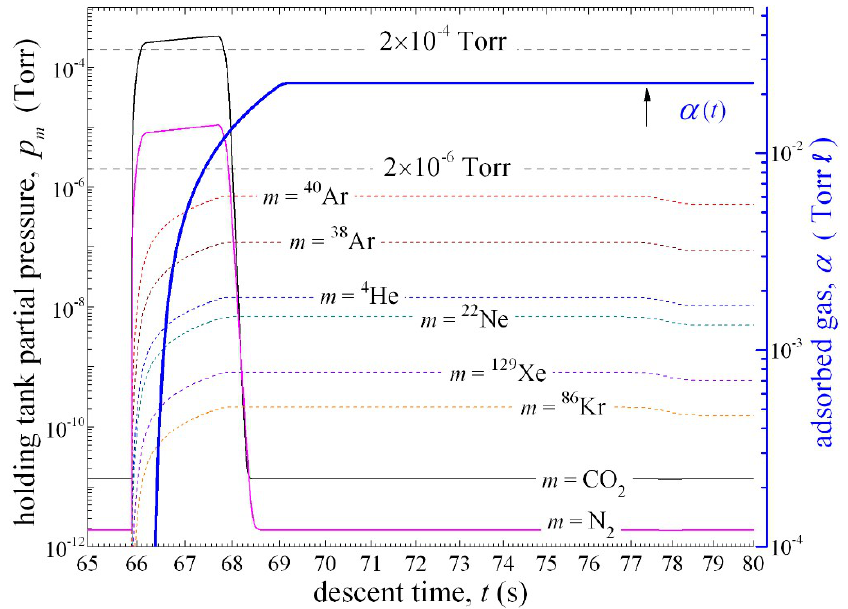
Figure 3. Evolution of partial pressures inside the holding tank due to 2 s of sampling and after the sample has been expanded into the vacuum chamber. For valve timing sequence, see Table 4.